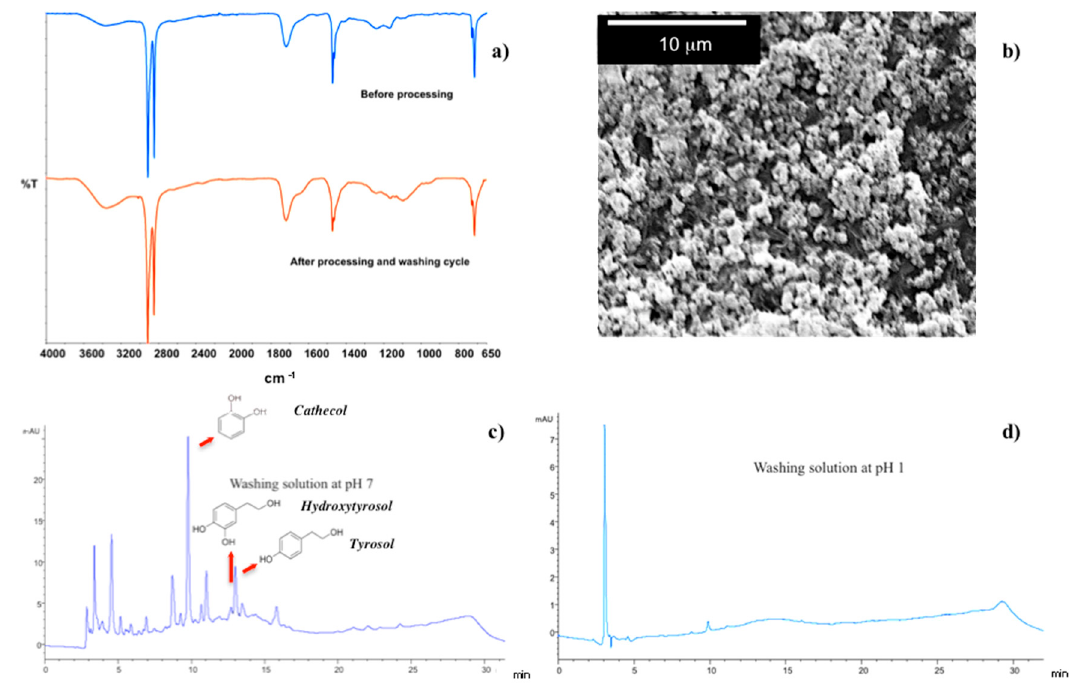
Figure 9. ATR spectra collected before processing and after washing the membranes at the end of microfiltration process ( a ); SEM micrograph collected onto the functional membrane surface after washing ( b ); HPLC chromatogram related to washing solutions at pH 7 ( c ) and pH 1 ( d ).